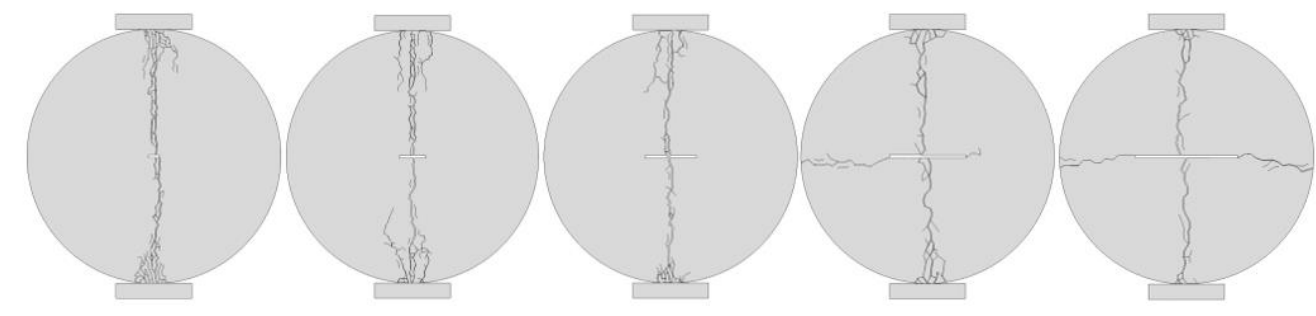
Figure 28. The failure mode for Brazilian discs with 45° cracks of different length. The crack lengths are 2 mm, 5 mm, 10 mm, 15 mm and 20 mm, respectively.